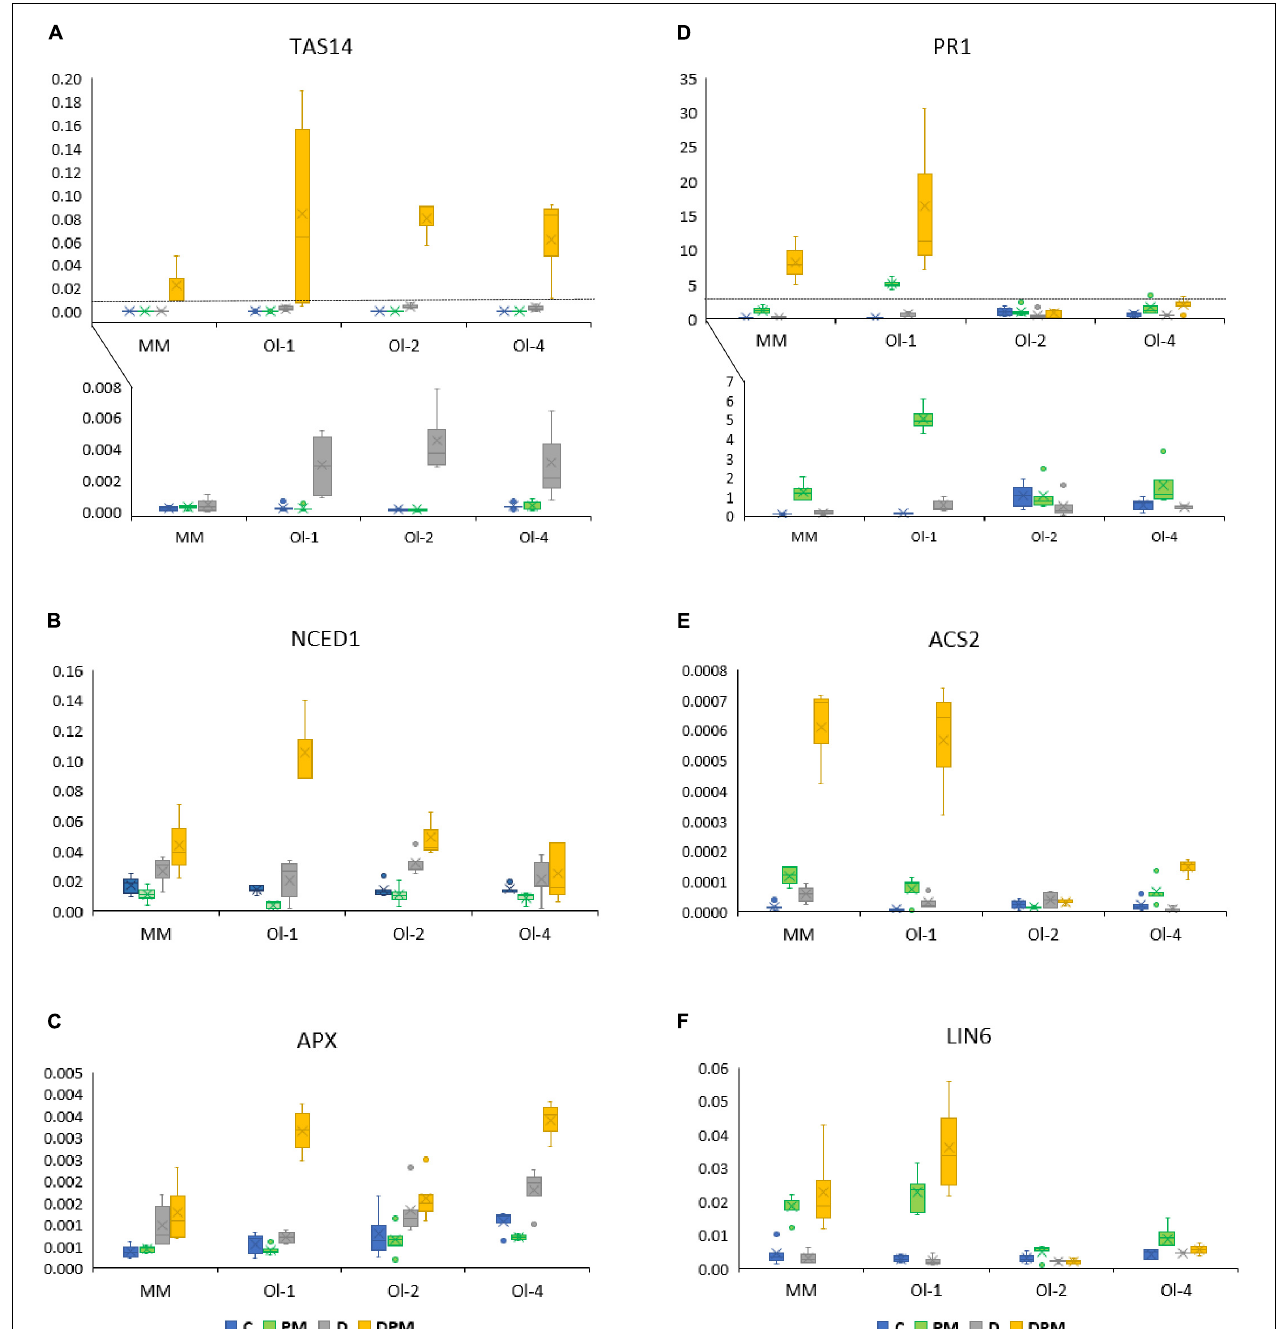
FIGURE 5 | (A–F) Expression of tomato marker genes for hormonal, abiotic and biotic stress signaling pathways in leaves of MM, NIL- Ol-1 , NIL- ol-2 , and NIL- Ol-4 , (written as Ol-1, ol-2, and Ol-4 in the figure) relative to the housekeeping gene SlEF1 α . C is control, PM is powdery mildew infection D is drought stress, DPM is combined drought and powdery mildew infection. Within each treatment, five plants per genotype were used for analysis.